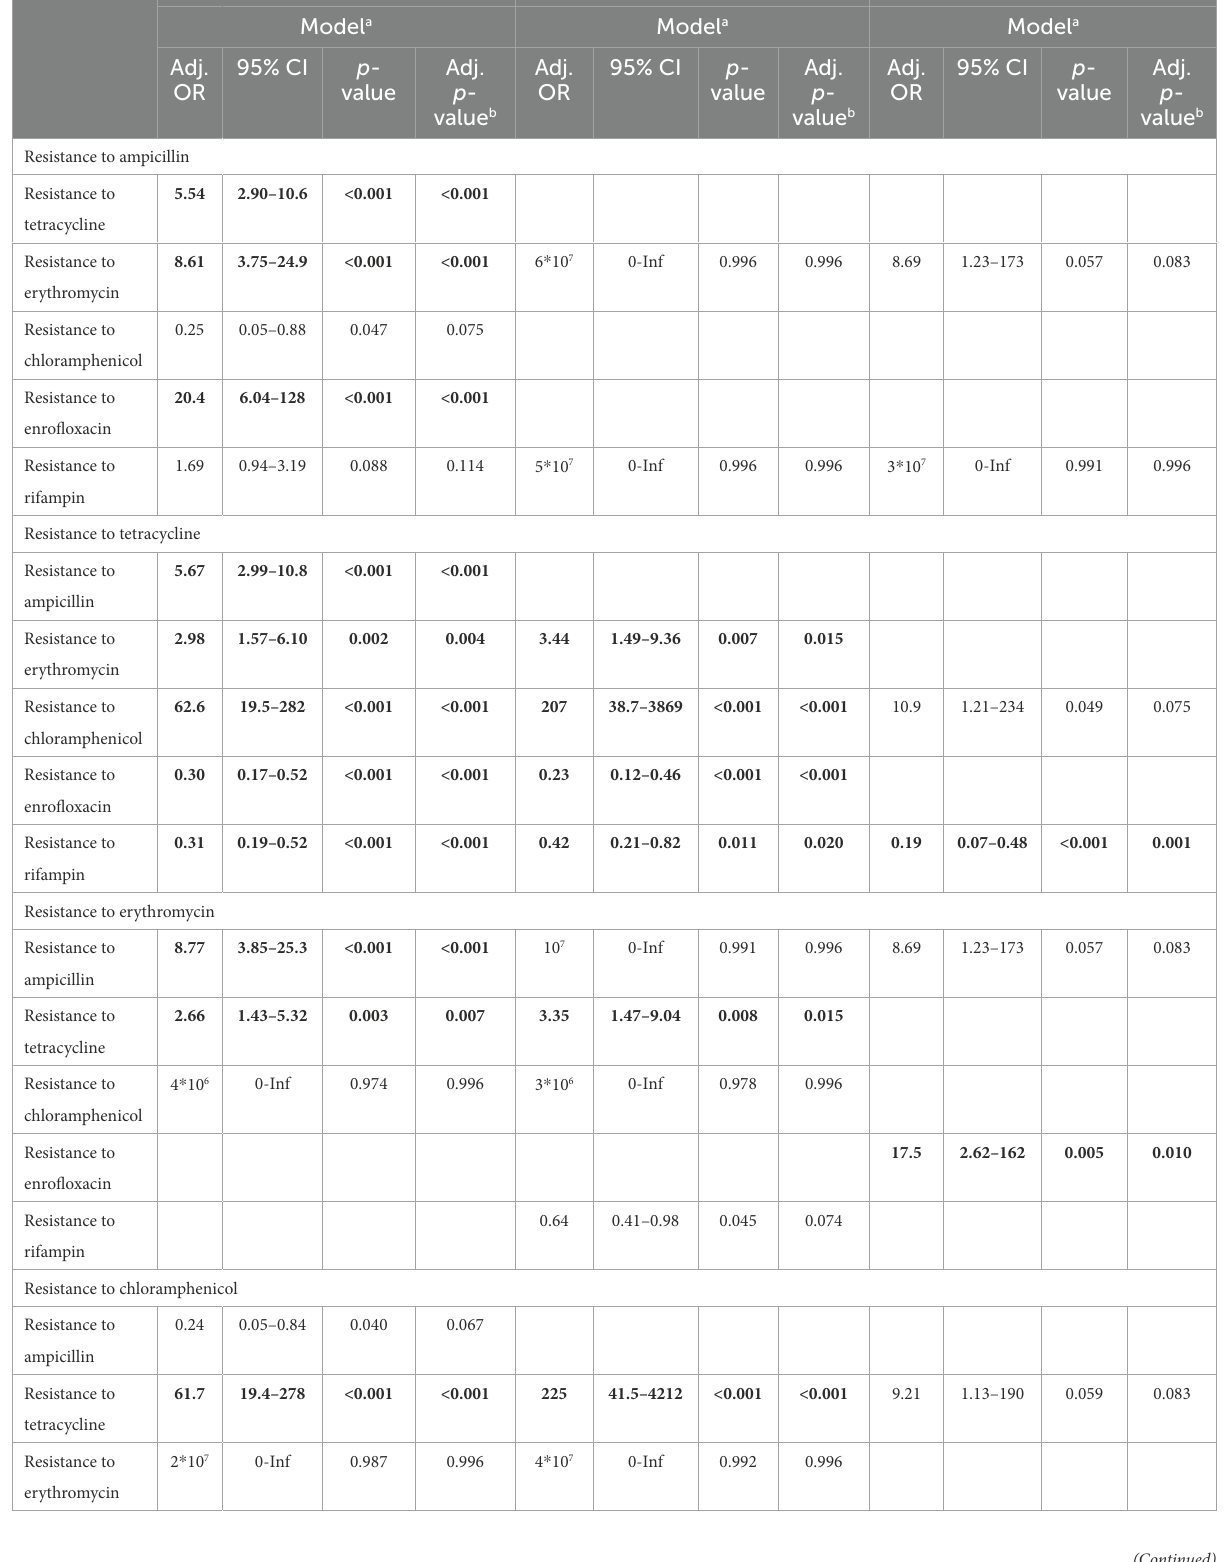
TABLE 5 Association between resistance to ampicillin, tetracycline, erythromycin, chloramphenicol, enrofloxacin, or rifampin and other antimicrobial compounds among Enterococcus spp. isolates using multivariable logistic regression models. Enterococcus spp. Enterococcus faecalis Enterococcus